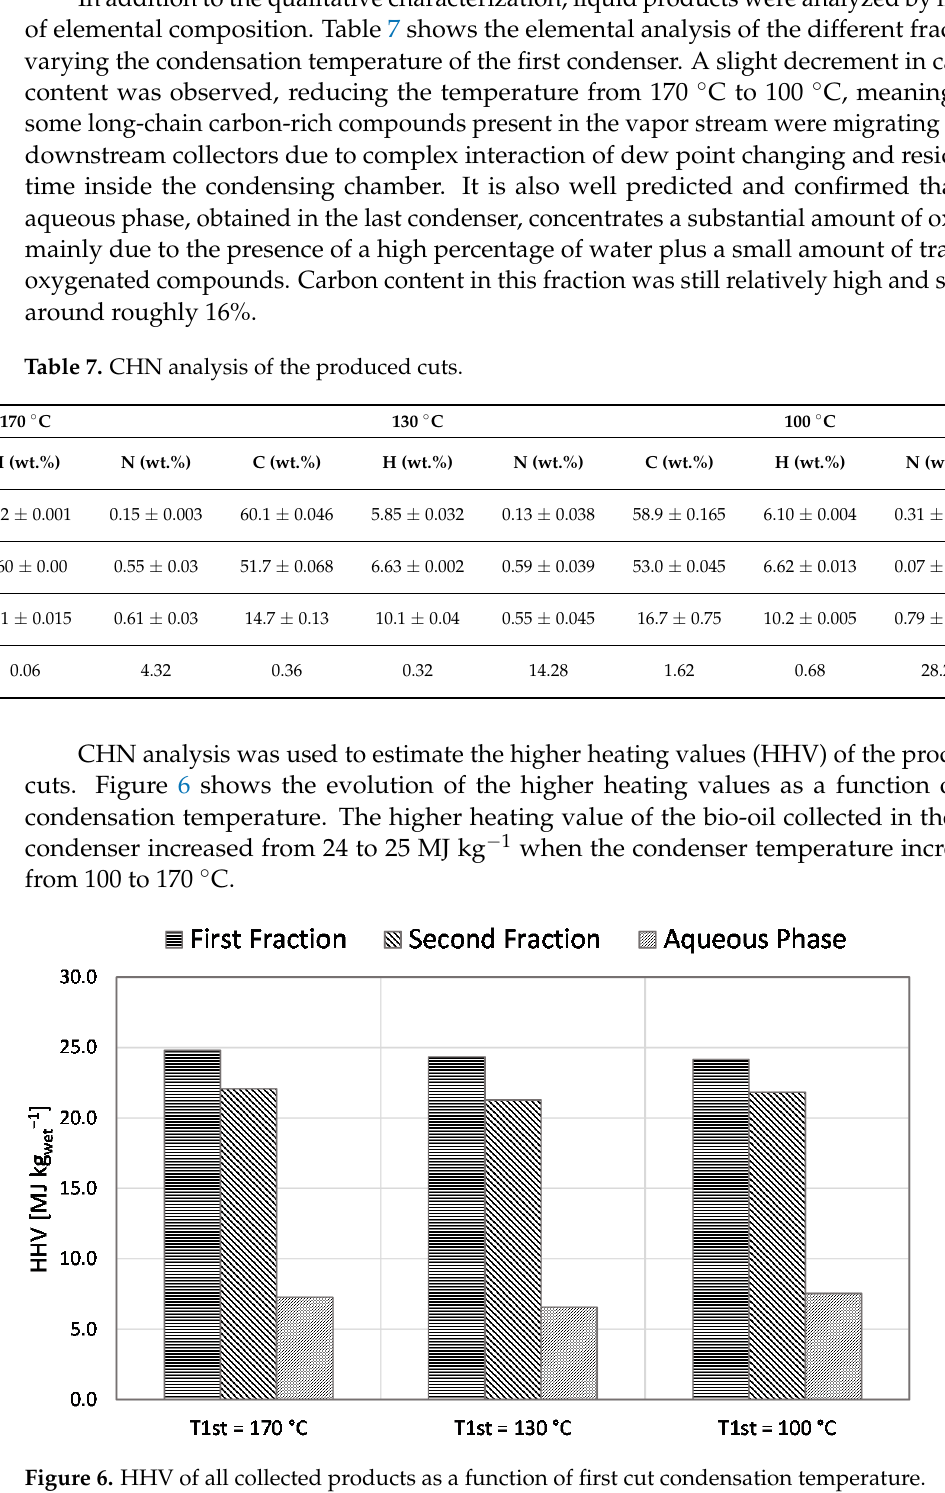
Figure 6. HHV of all collected products as a function of first cut condensation temperature.